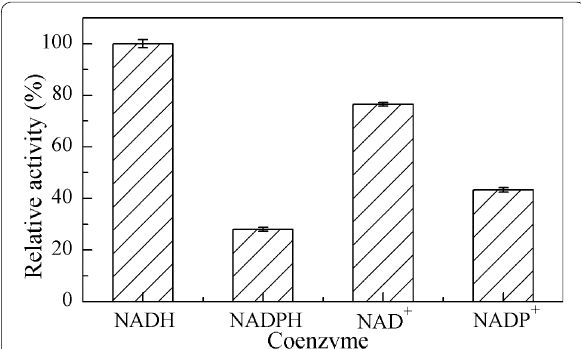
Fig. 3 Coenzyme preference of the recombinant AcCR. Reaction conditions: 0.25 mM NADH or NADPH (0.5 mM NAD + or NADP + ), 2 mL 50 mM citrate–phosphate buffer (pH 6.5 for the reduction or pH 8.0 for oxidation), and 5 mM 4 ′ ‑chloroacetophenone (150 mM isopropanol) were incubated for 5 min at 35 °C before adding 20 μL purified recombinant AcCR (about 0.008 mg of the purified